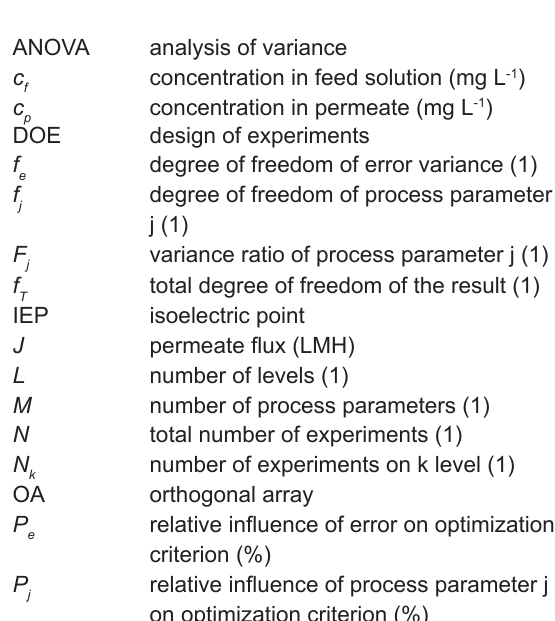
Figure 7. Zeta potential measurement for Al